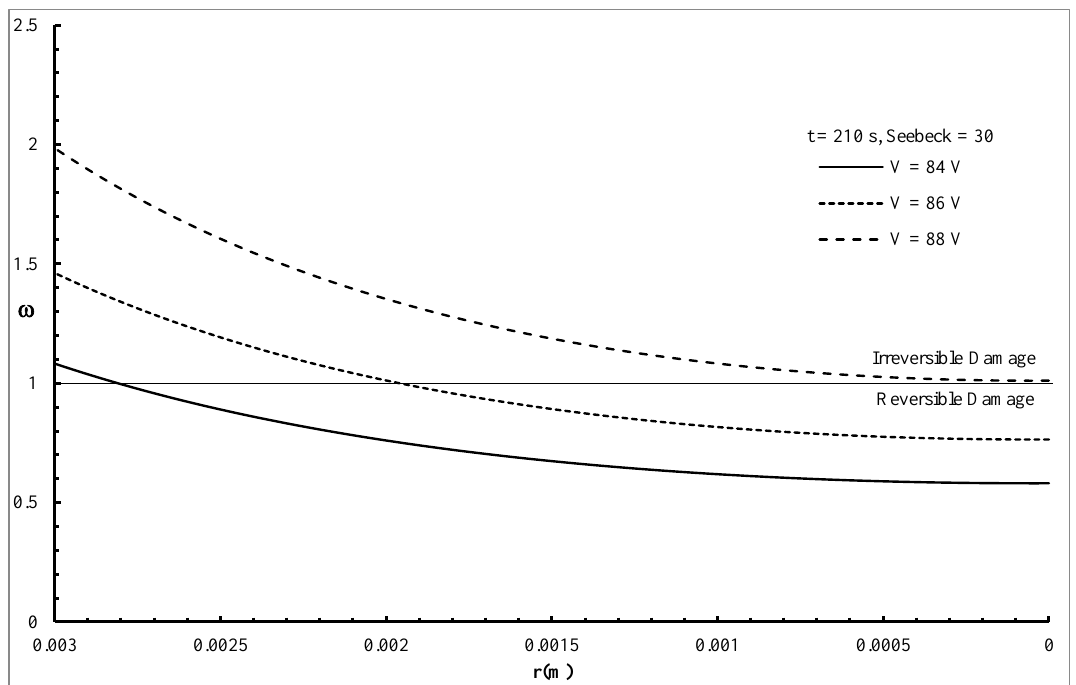
Figure 12. The thermal damage distribution of liposarcoma tumor with various values of voltage when R . 600 e